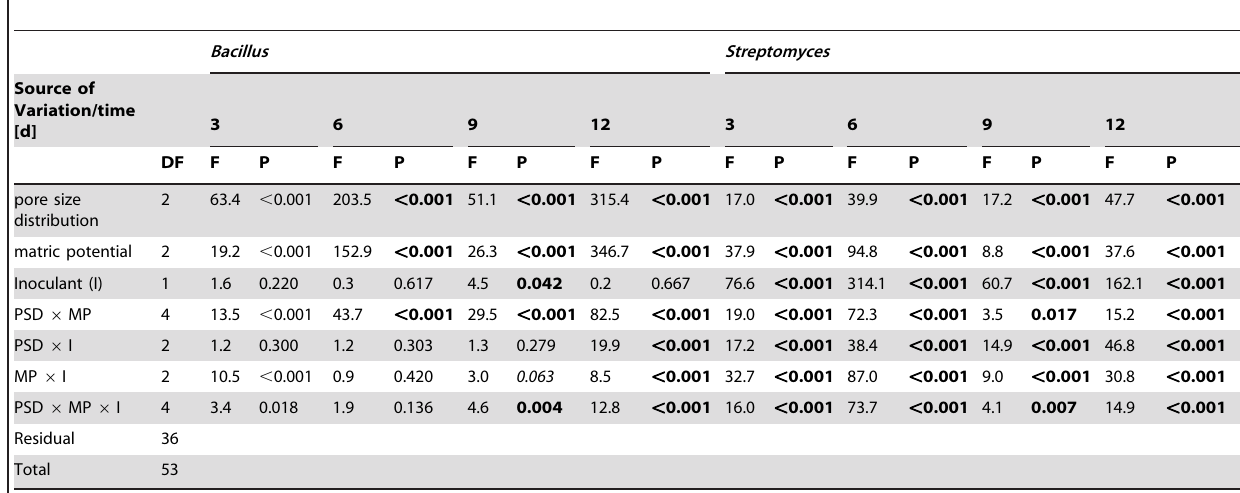
Table 3. Three-way ANOVAs of factors affecting population densities of Bacillus and Streptomyces strains after the given periods of incubation.